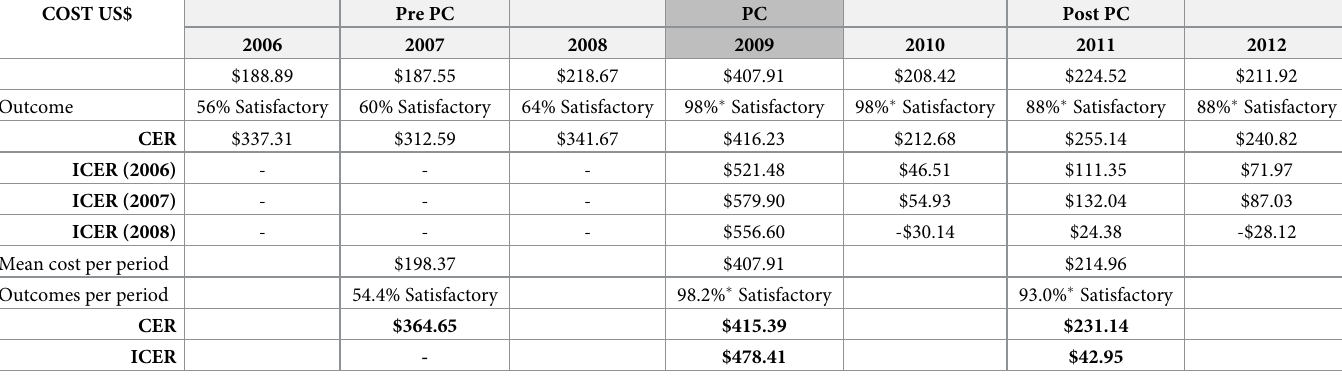
Table 3. Cost effectiveness ratio and incremental cost effectiveness ratio analysis per year and period considering the cost of embedded pharmaceutical care in the cost of the public health system with assistance to hypertensive patients.